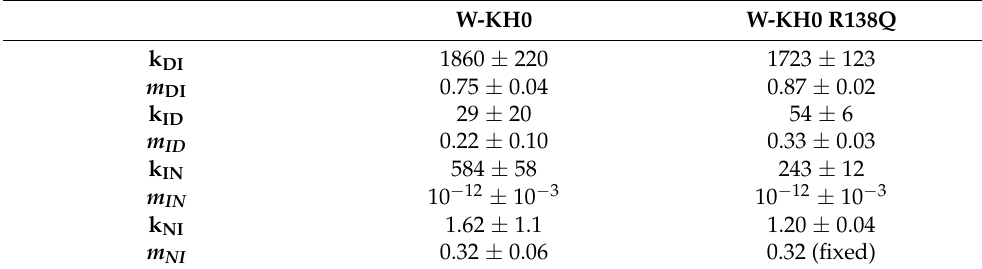
Table 2. (Un)folding kinetics parameters obtained for W-KH0 and W-R138Q-KH0 according to 3-state model with an on-pathway intermediate (D (cid:10) I (cid:10) N). Rate constants (k IJ ) are expressed in s − 1 and the associated m values ( m IJ ) are expressed in kcal mol − 1 M − 1